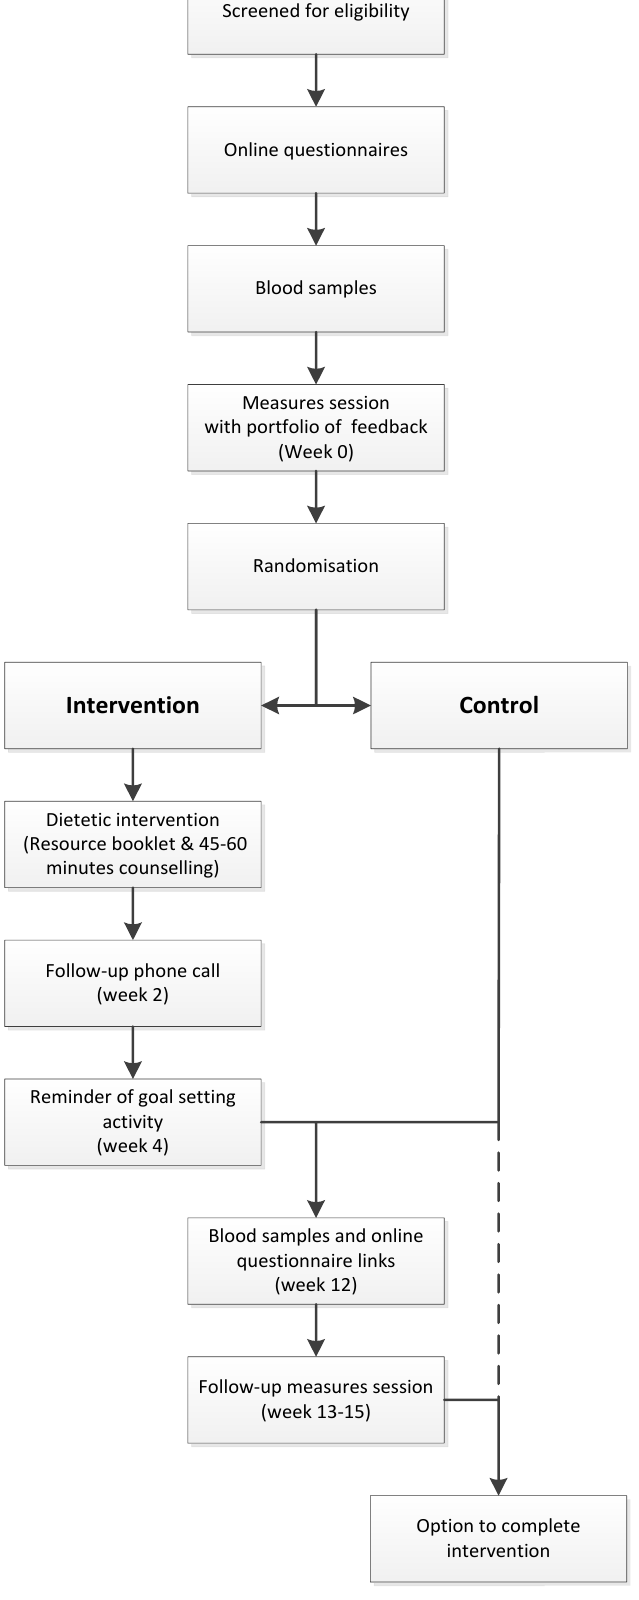
Figure 1. Intervention flow chart for study participants. Families randomized to the control group had the option of undergoing the intervention once the control period was completed.